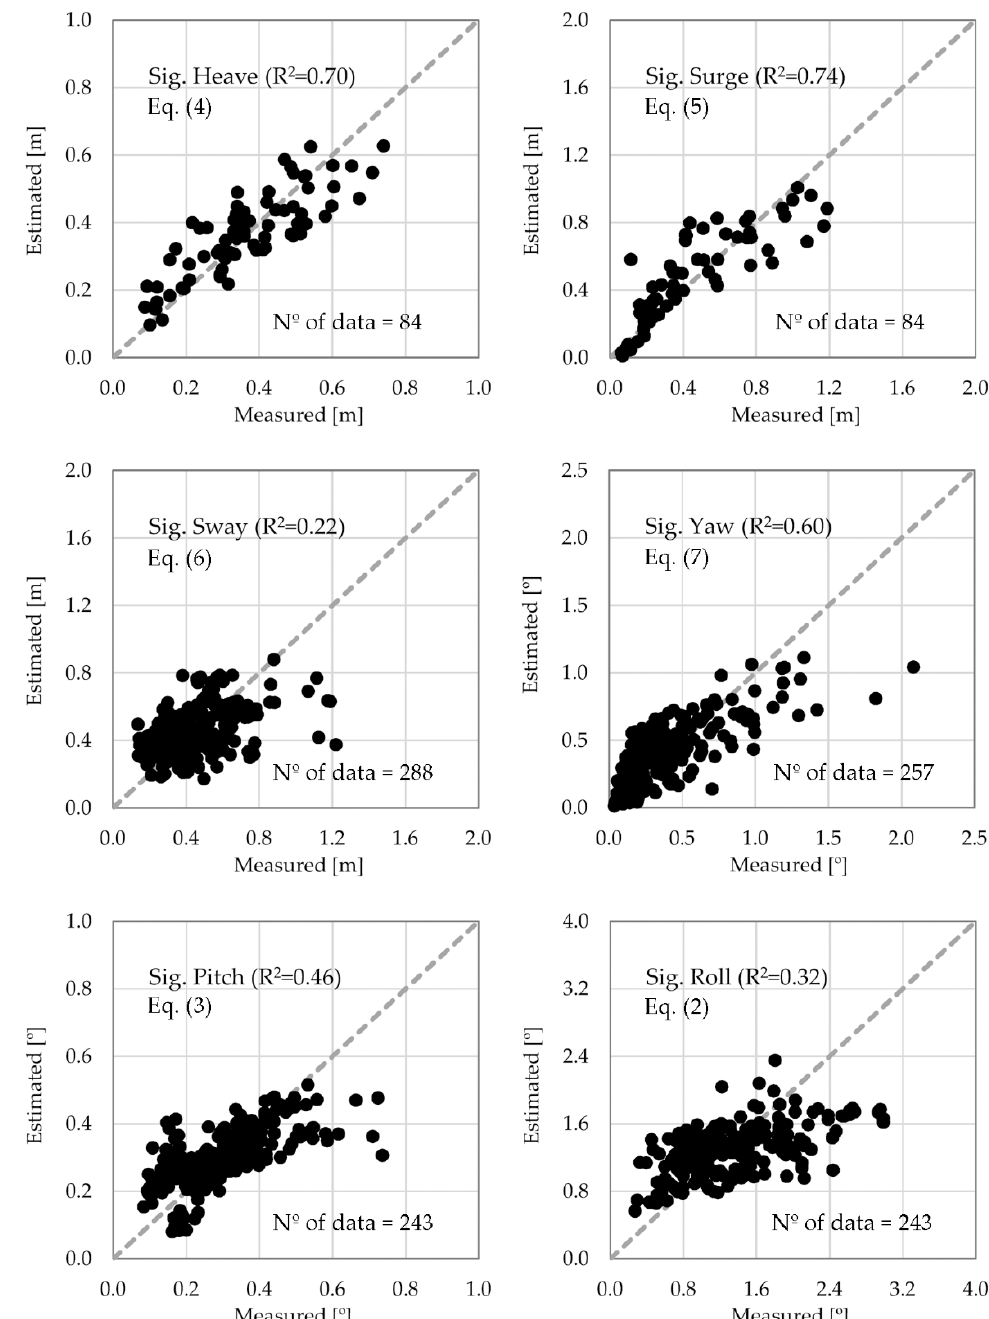
Figure 9. Validation of the multivariate linear models.